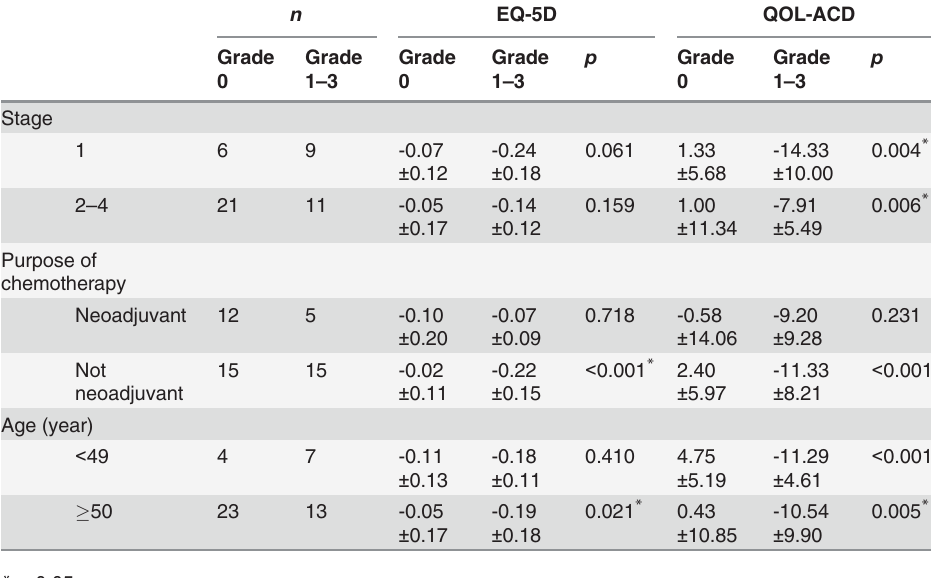
Table 9. Comparison of the EQ-5D utility value and QOL-ACD total score according to the presence or absence of anorexia in patients stratified by stage, purpose of chemotherapy and age.